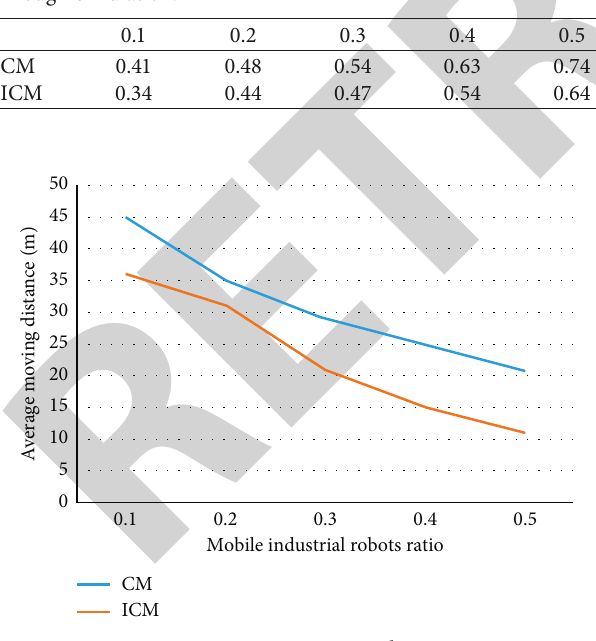
Table 3: Energy consumption ratio of CM and ICM compared through simulation.